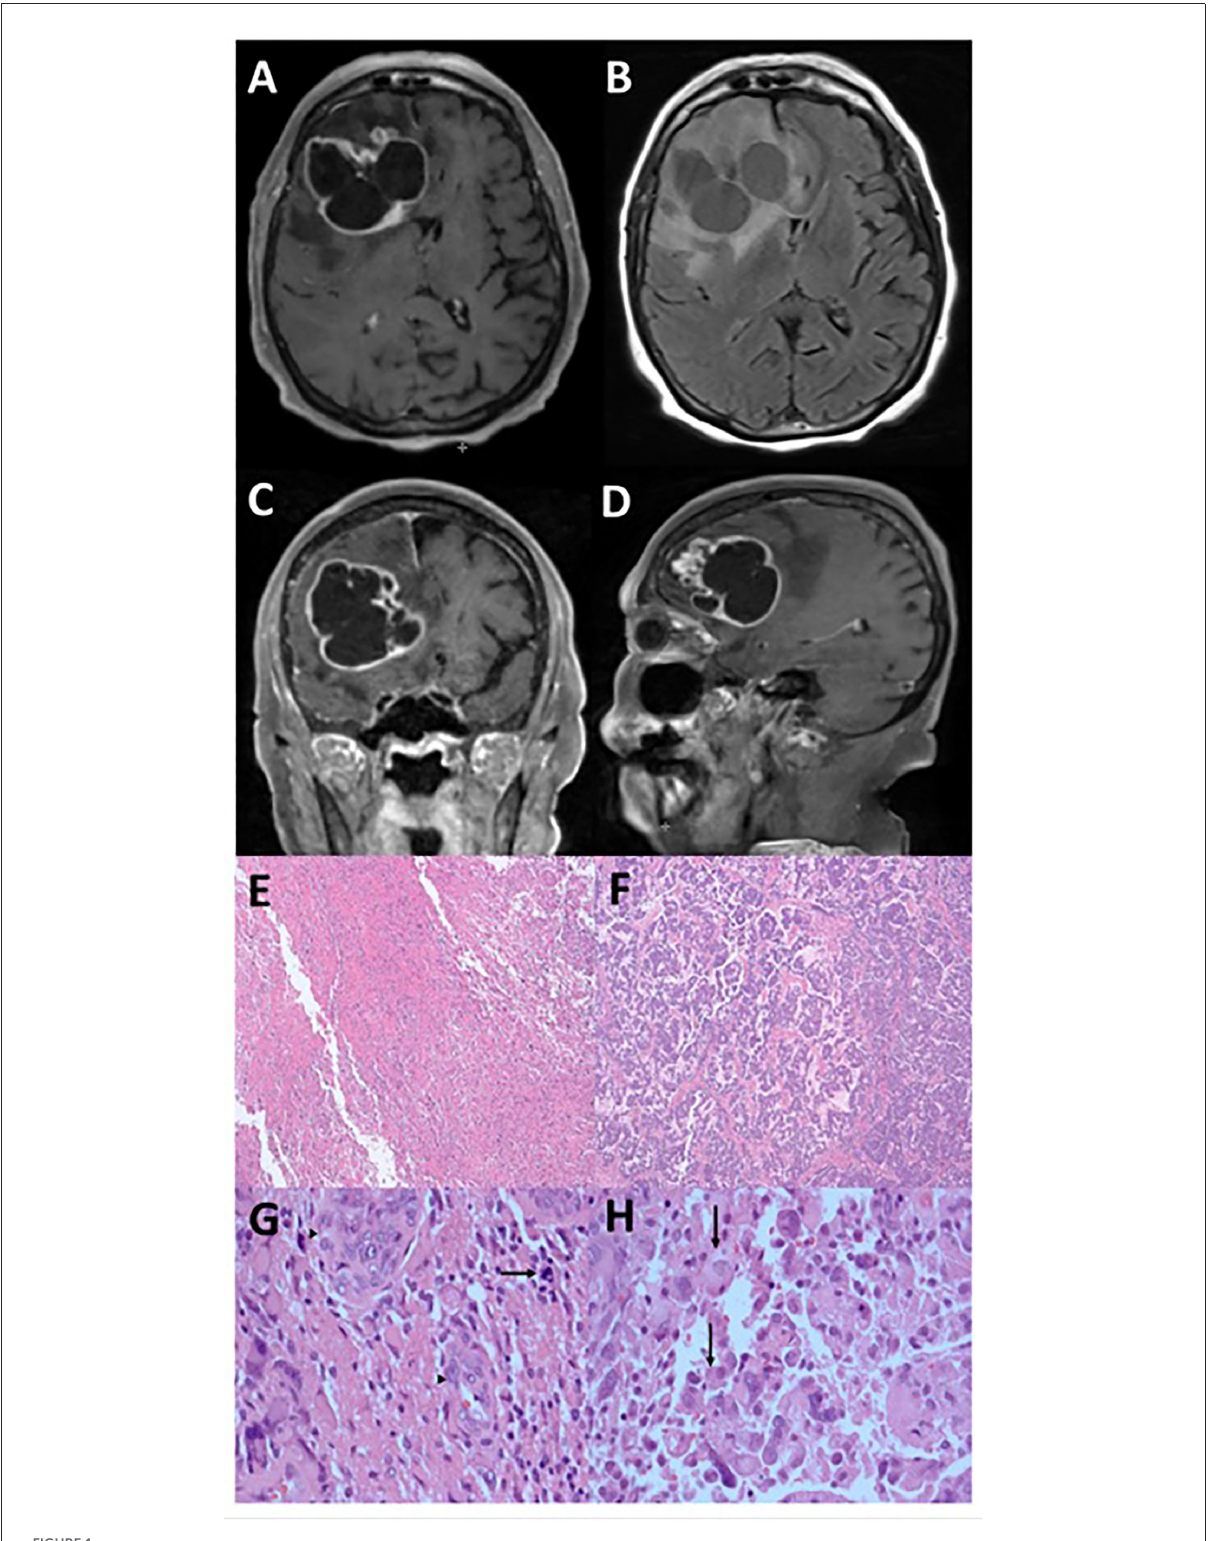
FIGURE1 Radiographic and microscopic features of epithelioid glioblastoma. This tumor has an irregular, multi-cystic enhancement seen on post-gadolinium T1-weight MRI sequence in the axial (A) , coronal (C) , and sagittal (D) orientations, accompanied by surrounding